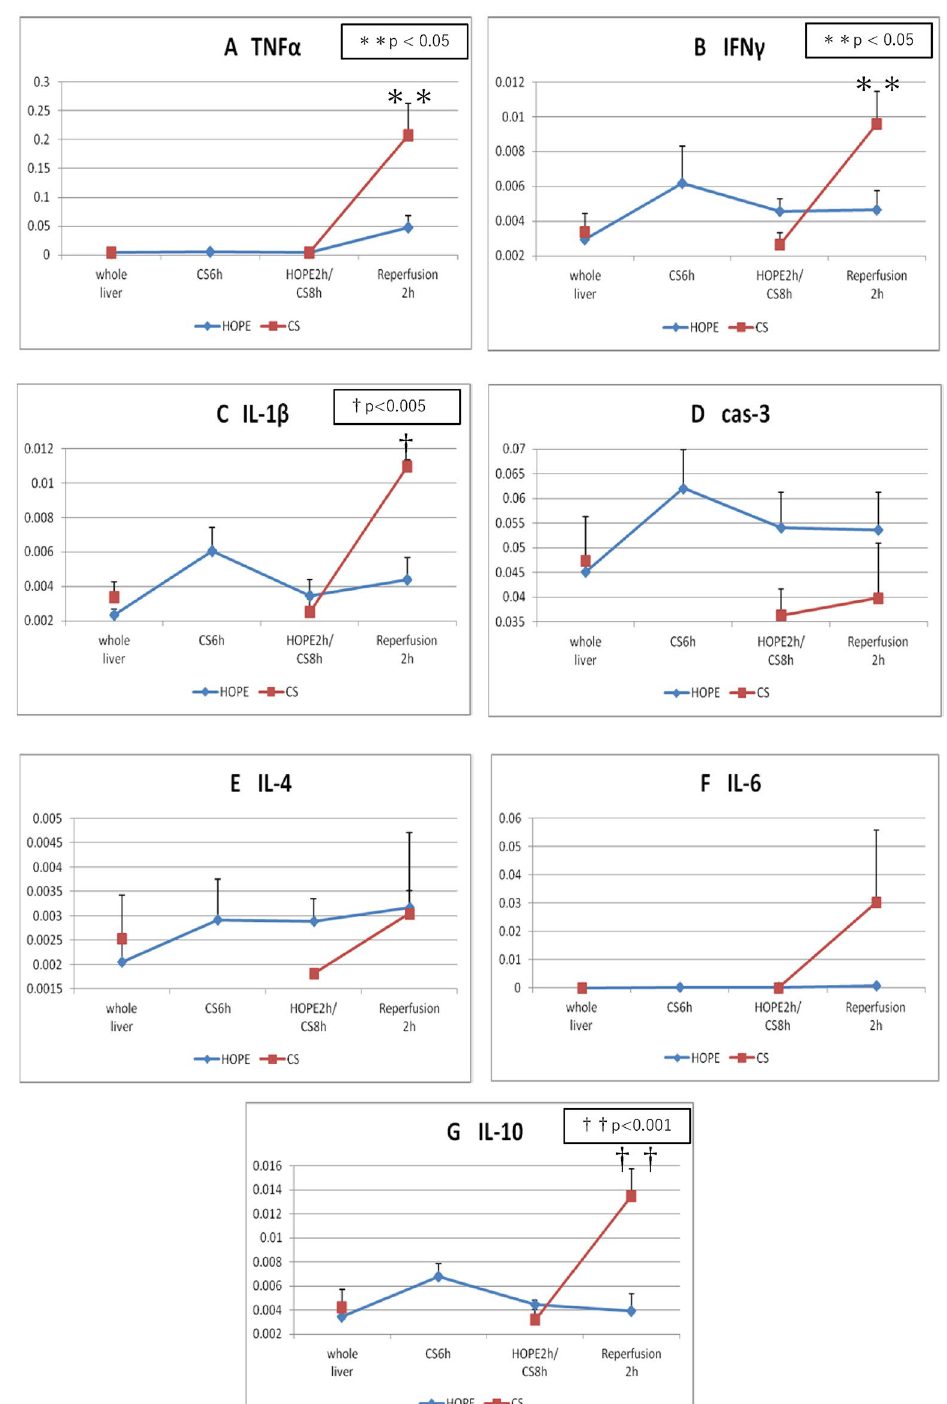
Figure 7. Polymerase chain reaction. ( A ) Tumor necrosis factor α, ( B ) interferon γ, ( C ) IL-1β, ( D ) caspase-3, ( E ) Il-4, ( F ) IL-6 and ( G ) IL-10 value (mean ± SD) after laparotomy, after preservation (simple CS and HOPE), and at 2 h after isolated ERM. CS cold storage, ERM ex vivo reperfusion model, HOPE hypothermic oxygenated machine perfusion preservation, IL interleukin, SD standard